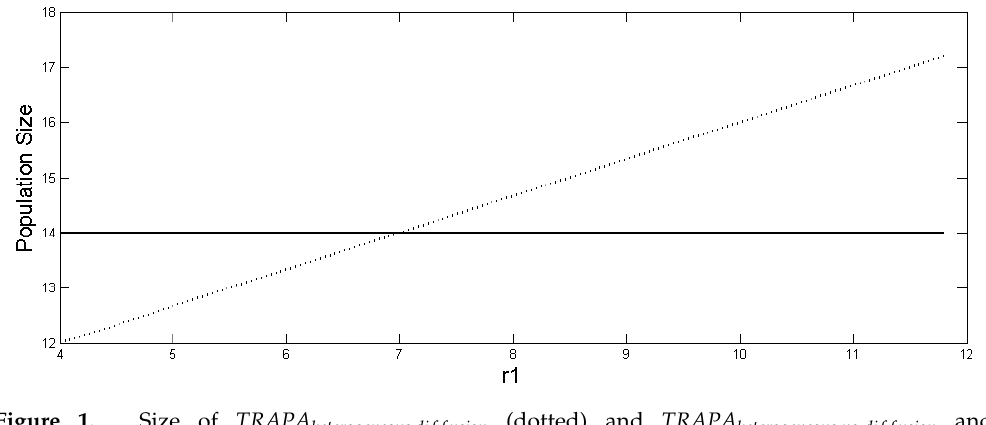
Figure 1. Size of TRAPA heterogeneous , diffusion (dotted) and TRAPA heterogeneous , no diffusion and TRAPA homogeneous , (solid, overlapping) as function of r 1 . The ratio r 1 / K 1 > r 2 / K 2 holds after r 1 > 7. The other parameter values are r 2 = 3.5, K 1 = 14, and K 2 = 7.